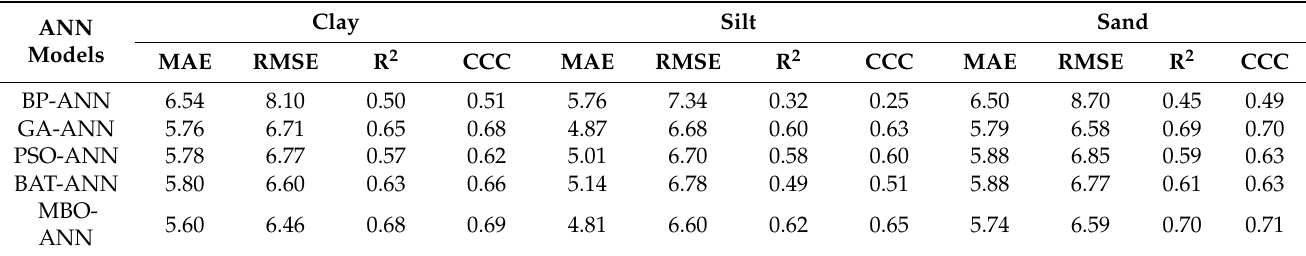
Table 3. Accuracy metrics of the five ANN models for predicting PSFs based on repeated 10-fold cross-validation. Clay ANN Models